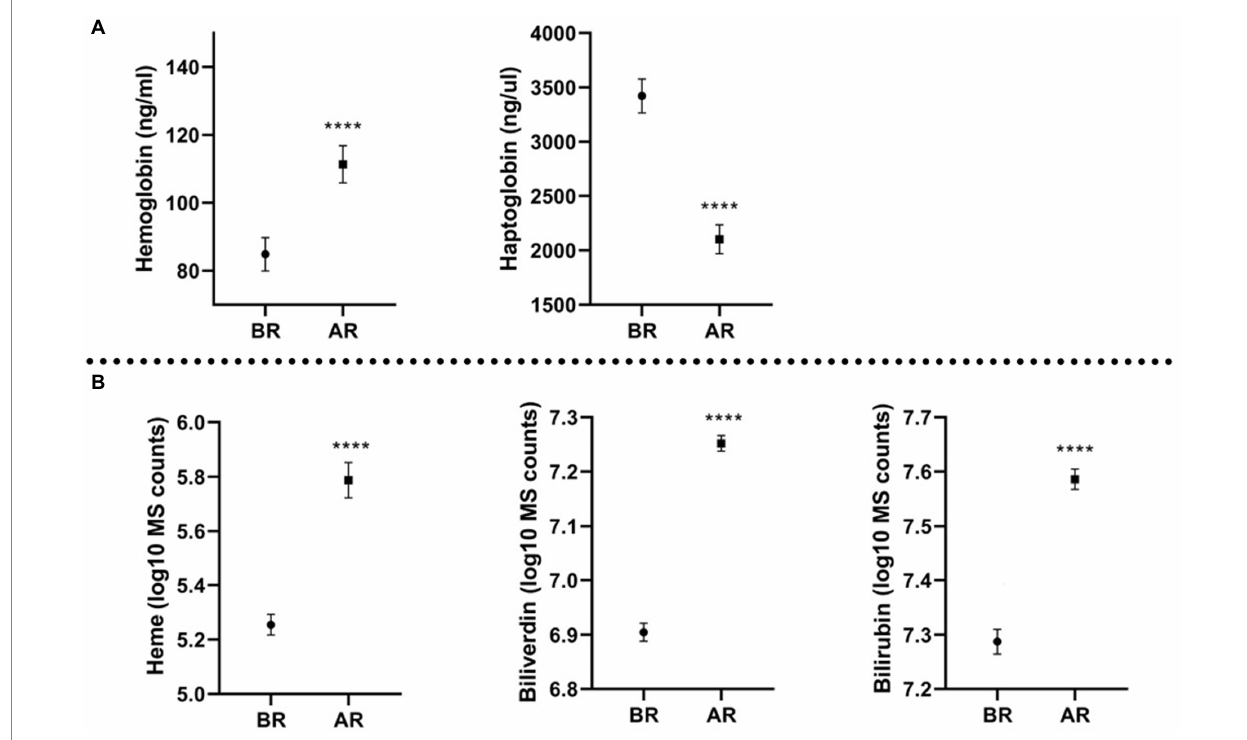
FIGURE 1 Molecules quantification (mean and standard error of the mean) before the race (BR) and after the race (AR); (A) molecules measured with ELISA, expressed in ng/mL (Hb) and ng/ μ L (Hp); (B) molecules measured with metabolomics platform, expressed in log10 MS counts; **** p ≤ 0.0001.